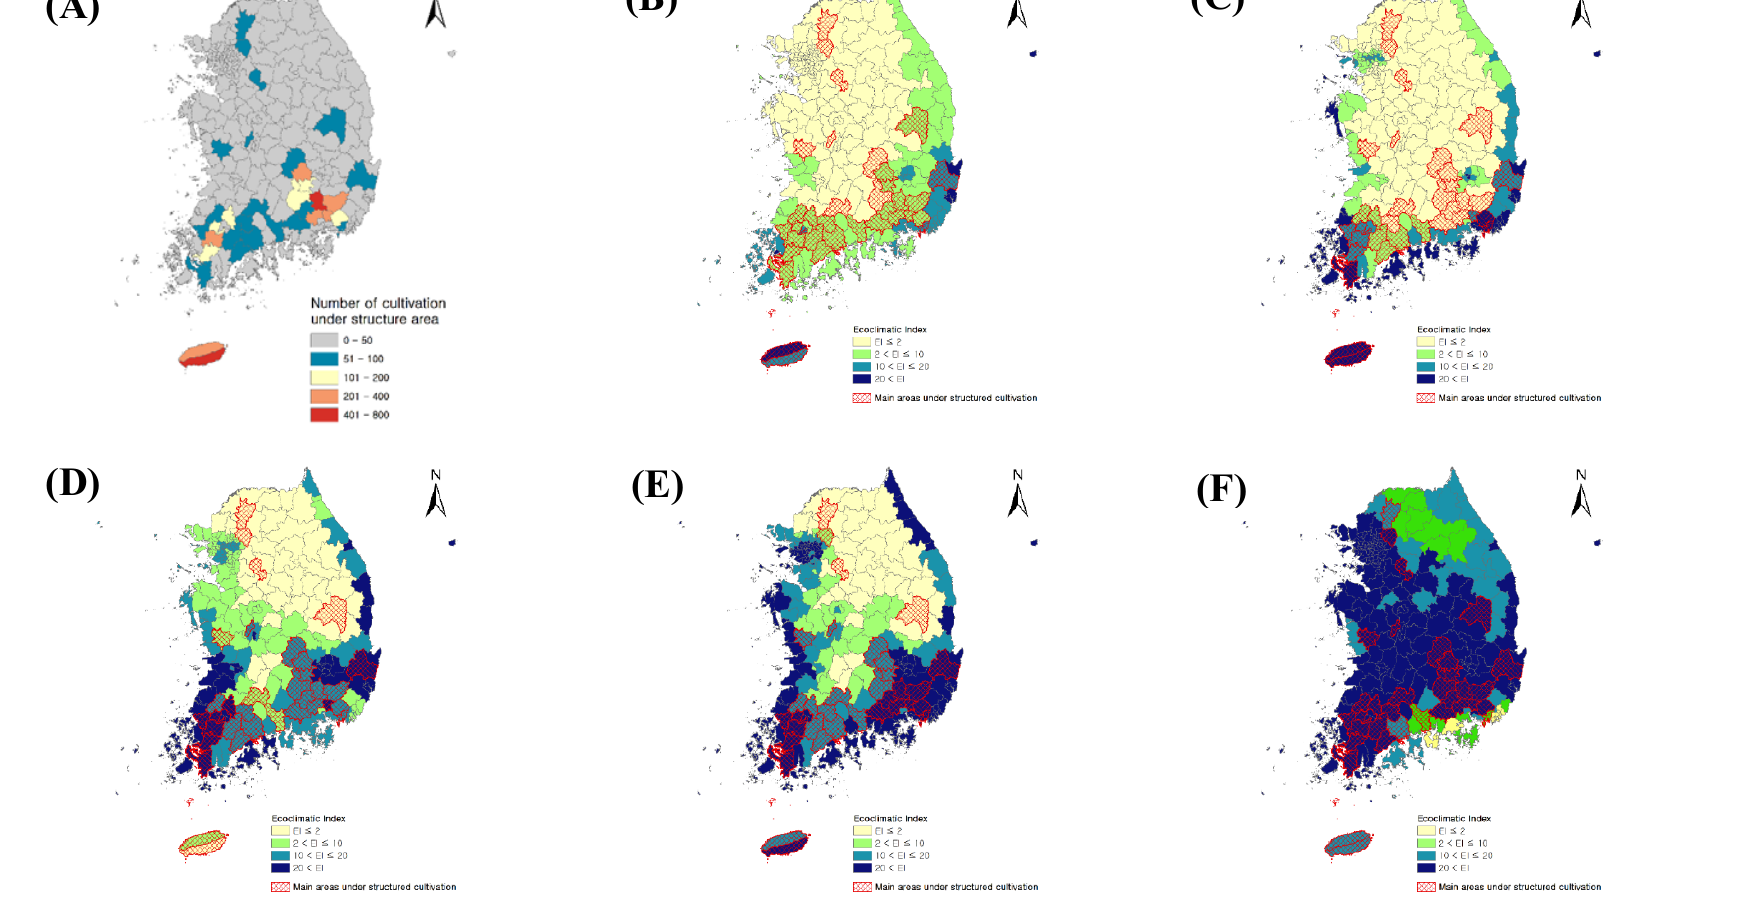
Figure 3. Map recording the number of cultivation areas under structure ( A ), and maps overlaid climatic suitability of the red imported fire ant and the number of cultivation areas (( B ): current; ( C ); 2040, ( D ): 2060, ( E ): 2080, and ( F ): 2100).